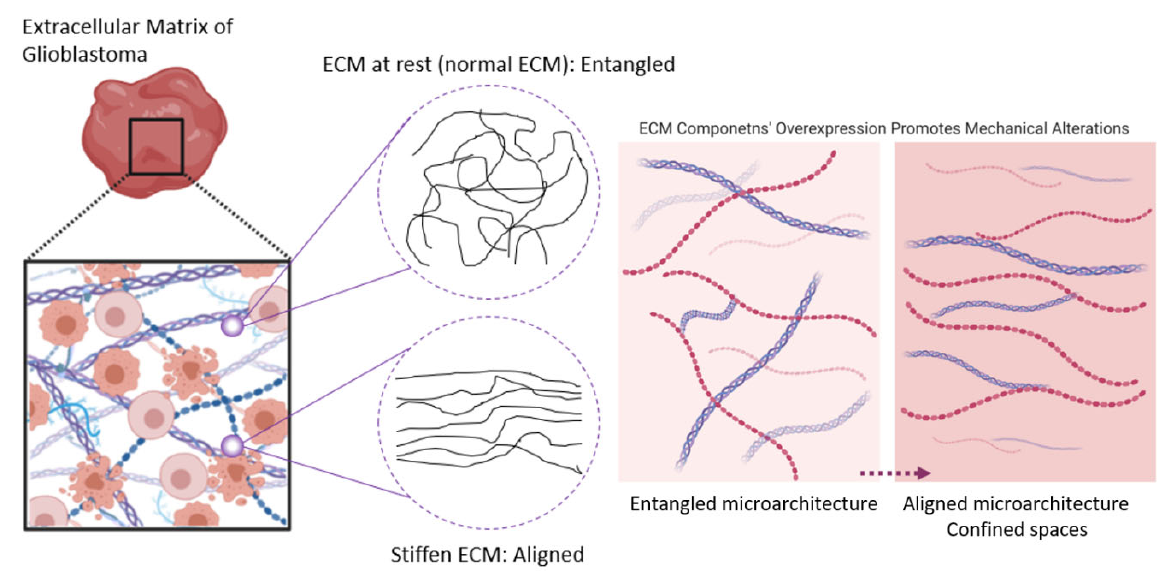
Figure 4. The brain ECM mechanics and microarchitecture in GBM. With extracellular matrix (ECM) alterations, as its stiffens, the brain tissue structure adopts confined spaces and reshapes its microarchitecture, generating compression and applying mechanical stresses to GSCs. Figure adapted from [73,78,80–83].